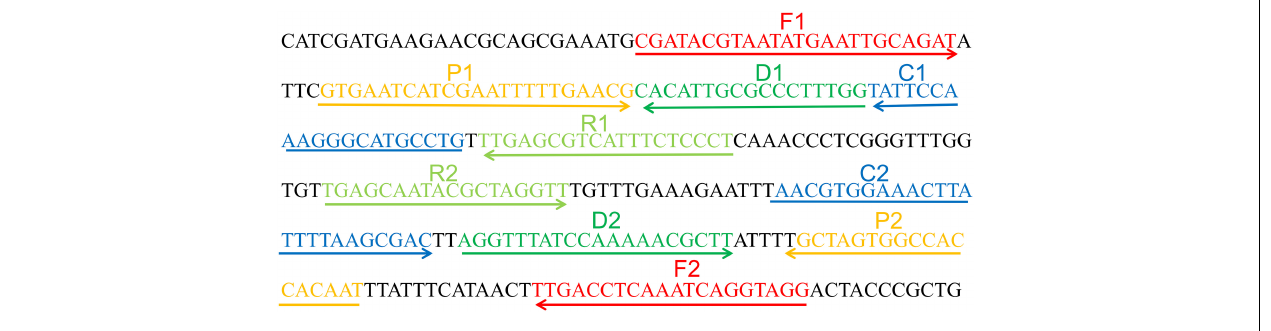
FIGURE 1 | Appropriate primer design for C. tropicalis MCDA-LFB assay and primer sequence positions in the selected fragment including ITS II.